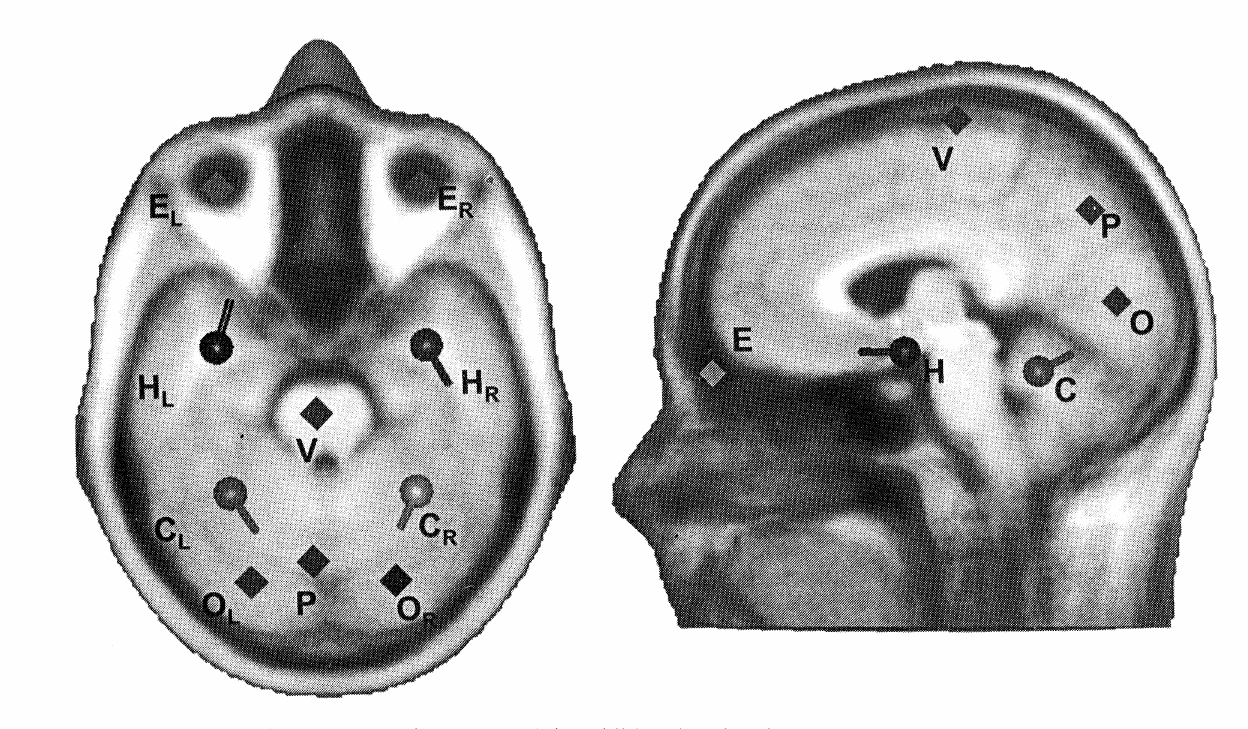
Fig. 1: Configuration of the dipoles of interest and the additional regional sources superimposed on a standardized brain image. Abbreviations are C for Cerebellum, H for Hippocampus, E for Eyes, 0 for occipital site, V for vertex and P for parietal site. Additional characters L and R indicate left and right